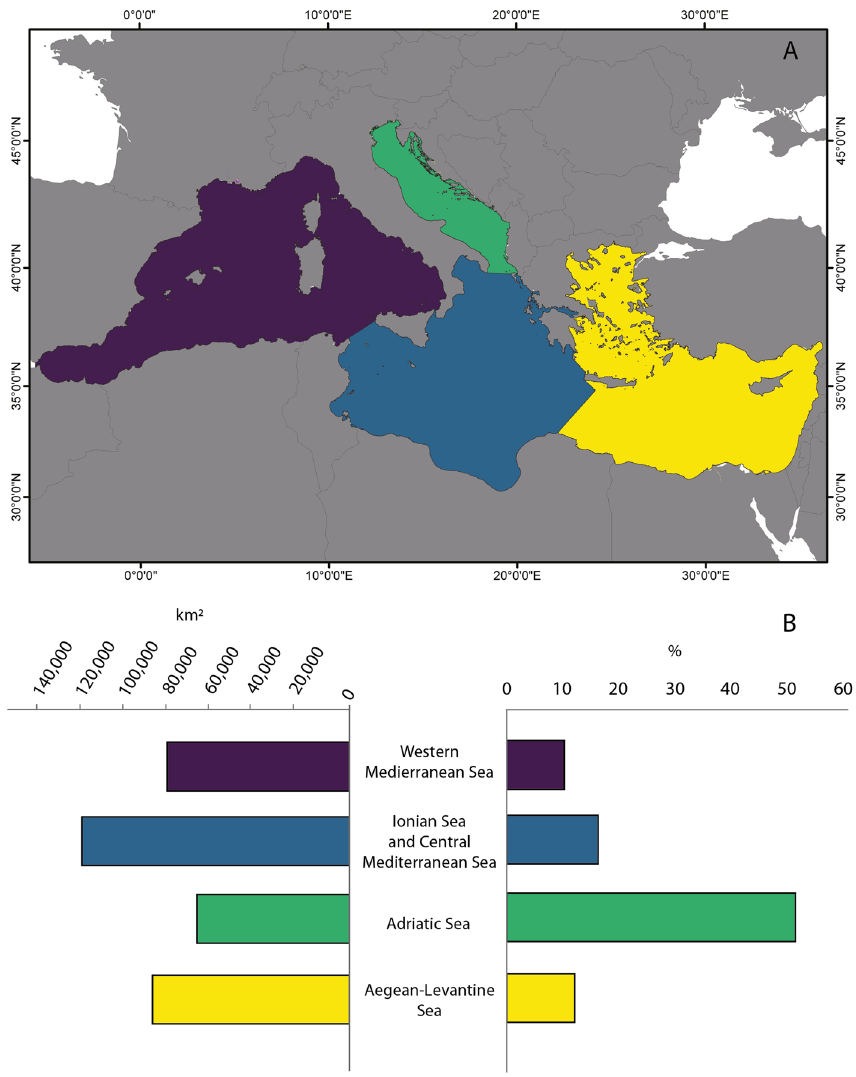
Figure 3. Portion of seabed under mesophotic conditions among Mediterranean sub-regions. ( A ) Sub-regions of the Mediterranean Sea according to the MSFD (2008/56/EC); Western Mediterranean Sea (purple): ca. 844,417 km 2 ; Ionian and Central Mediterranean Sea (blue): 772,705 km 2 ; Adriatic Sea (green): 139,300 km 2 ; Aegean-Levantine Sea (yellow): 756,642 km 2 . Map generated using ArcMap 10.5 software (© ESRI, https:// deskt op. arcgis. com). ( B ) Bar plot showing the portion of seabed under mesophotic conditions in the different MSFD sub-regions in terms of km 2 and areal